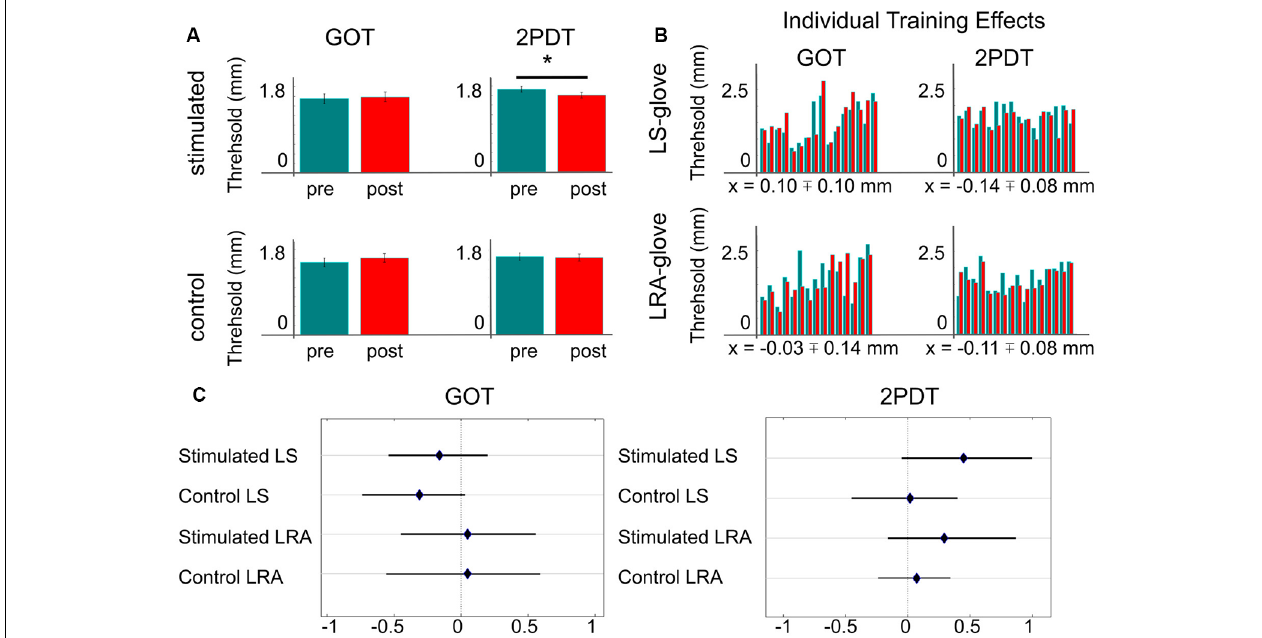
FIGURE 2 | Effect of repetitive somatosensory stimulation using loudspeakers or LRAs on GOT and 2PDT thresholds. (A) Averaged thresholds over both stimulators (loudspeaker-glove + LRA-glove). *Indicates significant difference at p < 0.05, uncorrected. (B) Individual training effects, one bar-pair shows values of one individual; green = pre-training thresholds of the trained finger, red = post-training thresholds of the trained finger, x = mean training effect ± SE; note that negative values indicate better performance after the training compared to before the training, LS, loudspeaker; LRA, linear resonant actuator. (C) Effect sizes of stimulation/no stimulation on 2PDT and GOT thresholds, dependent on glove type (LS/LRA); shown are Hedges’ g and 95% confidence